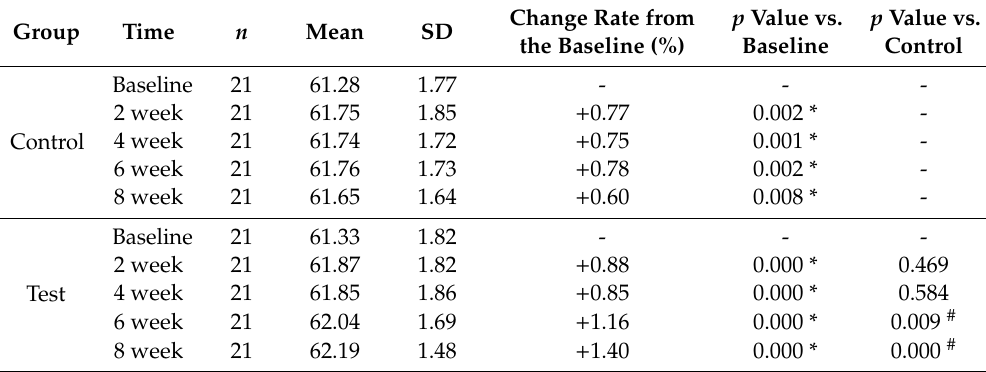
Table 6. Skin lightness (L* value) of the control and test groups.